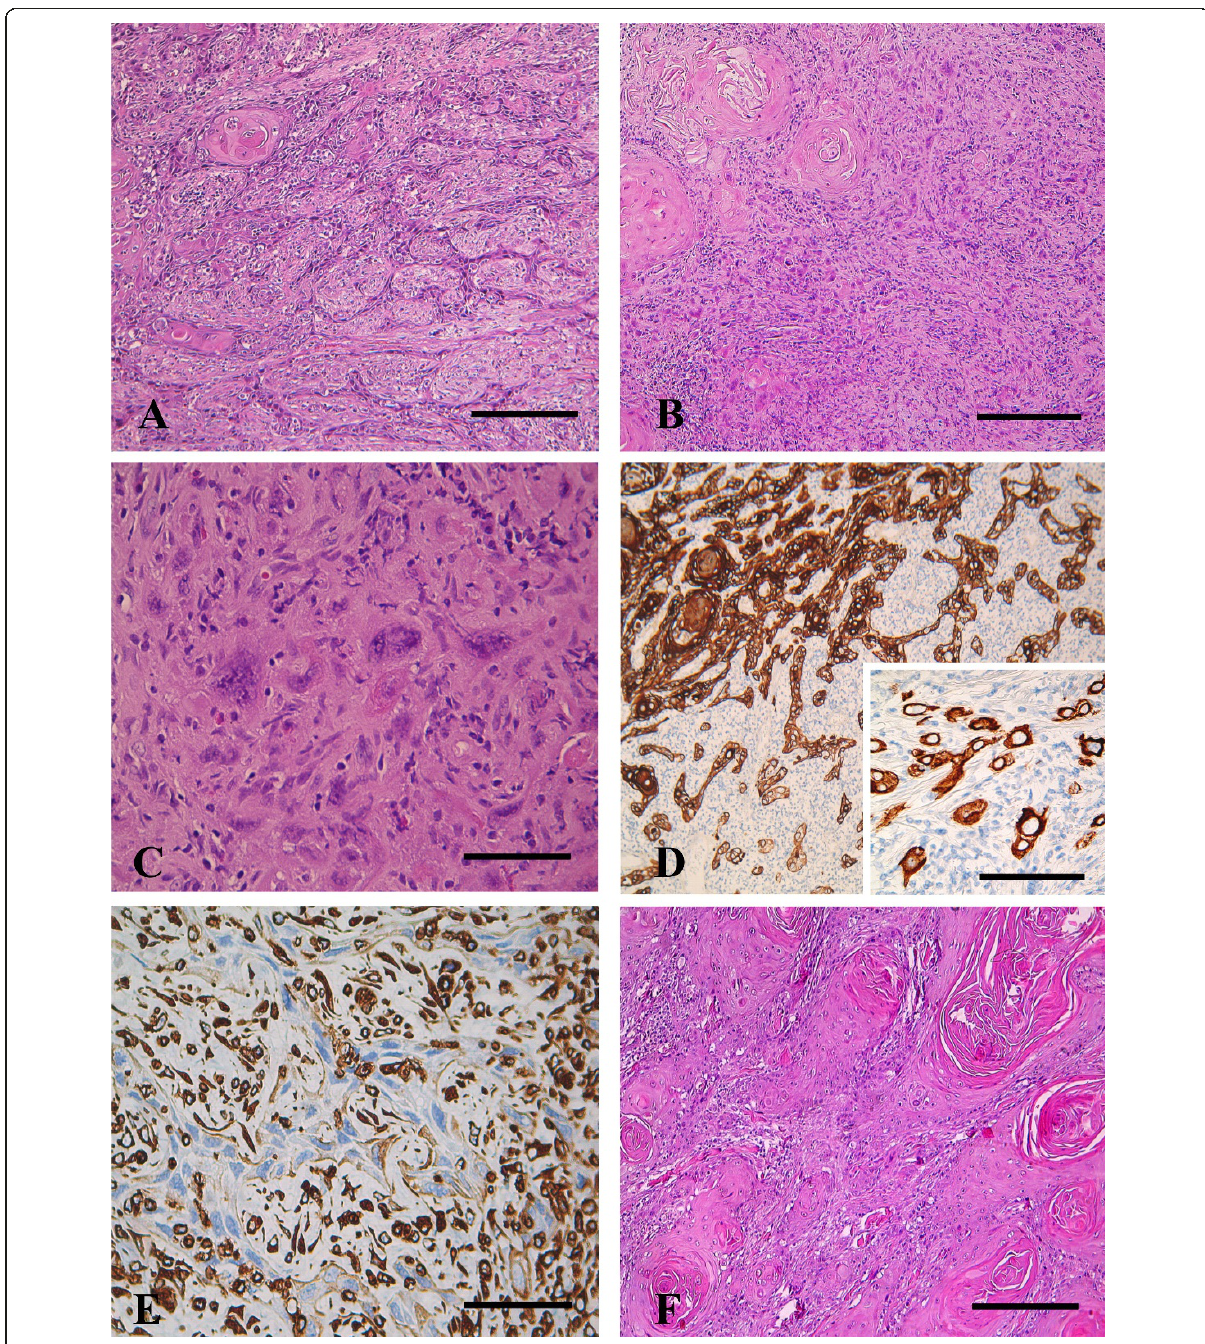
Figure 1 Vulvar squamous cell carcinoma with sarcoma-like stroma (A, B, C, D, E tumor features at presentation site; F local tumor recurrence) . A, B . Good squamous differentiation with keratinous pearls at tumor surface (upper-left corner in A and B) and less differentiated, spindle shaped cells in deeper portions of the tumor (right in A and B). Presence of scattered anaplastic, pseudosarcomatous cancer cells in a dense reactive stroma is shown in B (hematoxylin and eosin stain). C . At higher magnification ill defined cell borders are better seen (hematoxylin and eosin stain). D . Tumor cells presented positive for cytokeratins, more in the superficial, better differentiated portion of the tumor (upper-left corner). Inset shows the presence of reactivity for Cytokeratin in the isolated, giant neoplastic cells (Monoclonal Mouse Anti- Human Cytokeratin High Molecular Weight, clone 34 b E12, DAKO, Carpinteria, CA, USA). E . Vimentin stain highlights a thick reactive vascular stroma, whereas giant and spindle shaped tumor cells appear negative (central portion of picture) (Dako, Carpinteria, CA, USA). F . Local tumor recurrence. Note the higher degree of tumor differentiation with abundance of keratinous pearls in this representative histological field (hematoxylin and eosin stain). Bars are 100 μ m in A, B, D, F; 50 μ m in E and D inset; 25 μ m